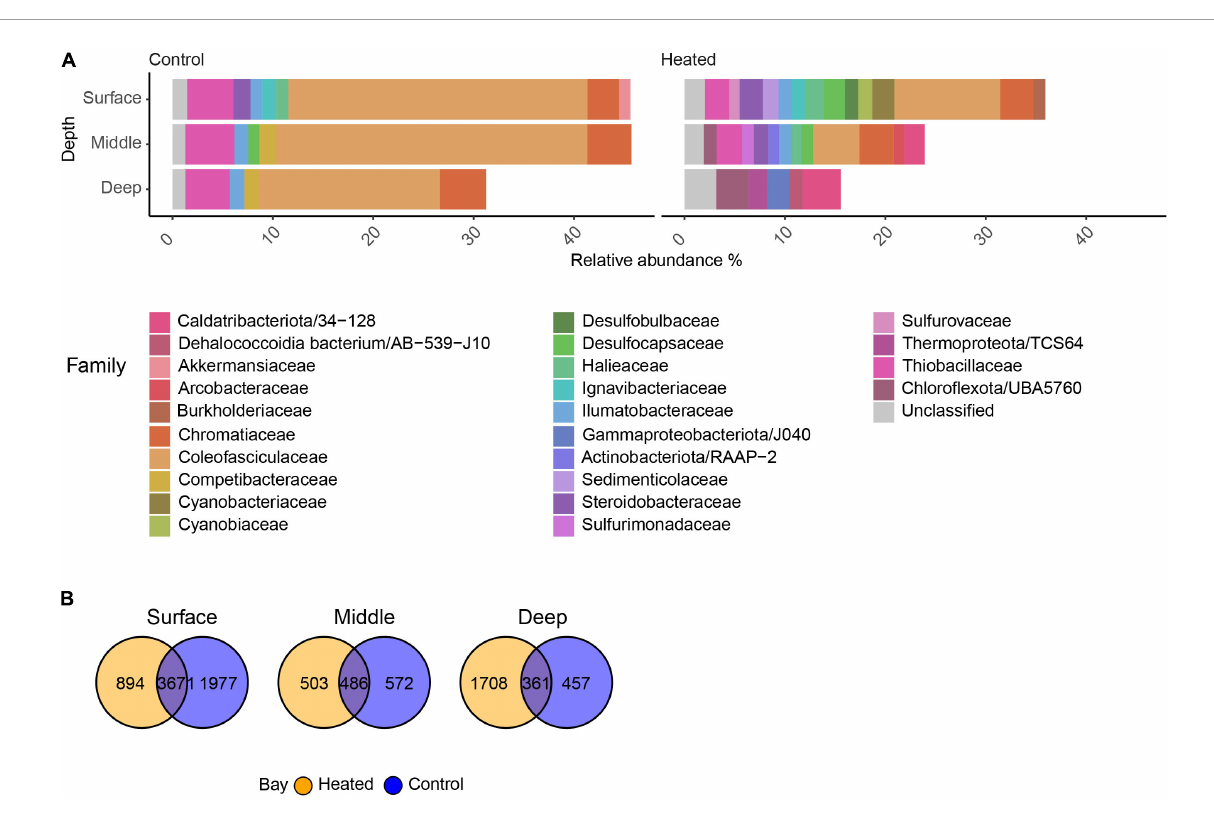
FIGURE4 Significant differential abundant families with relative abundance above 1% and a log 2 fold change of at least two within the heated and control bay at the three different depths (A) and venn diagrams of the significant ASVs within the heated and control bays at the three sediment depths (B)